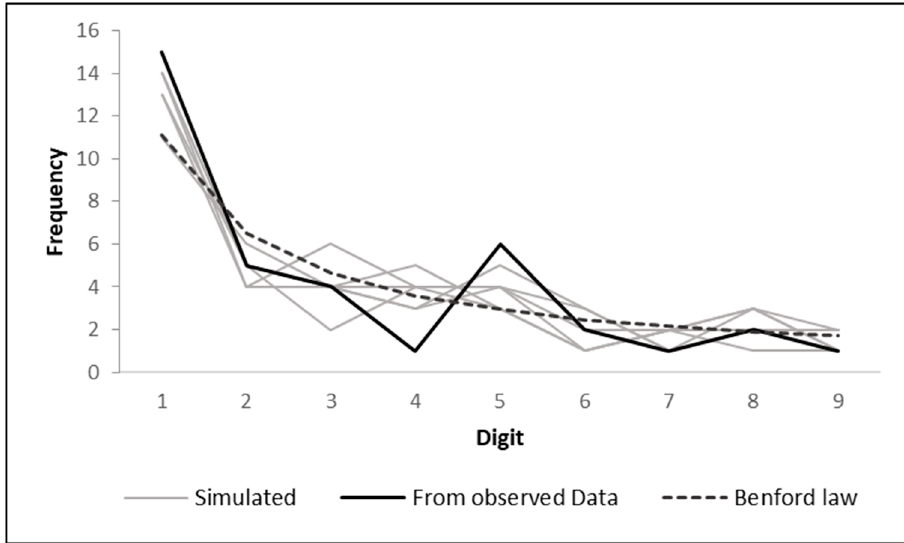
Figure 4. Benford count. Observed series and simulations.